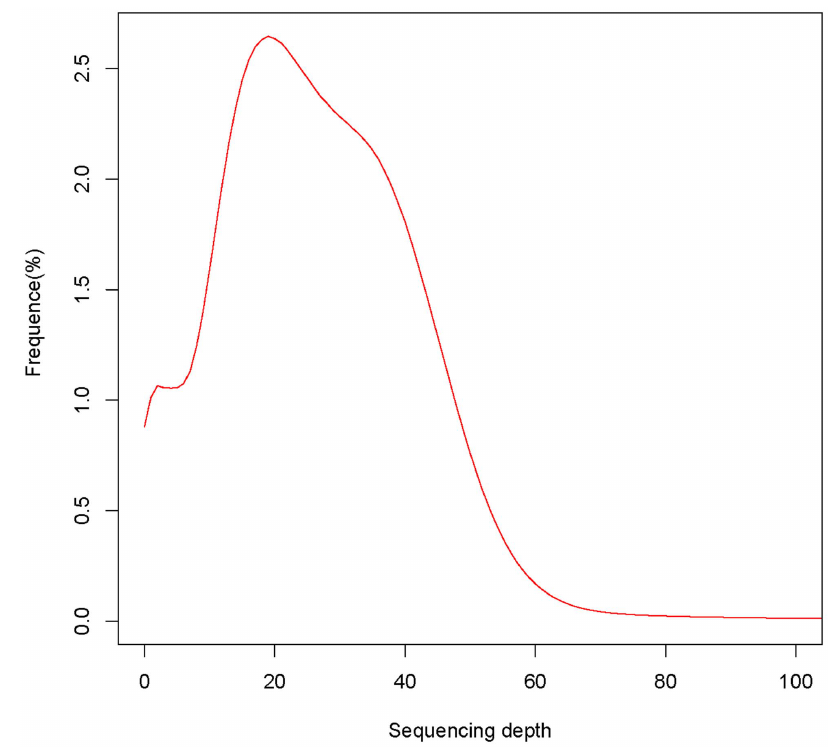
Figure 1. Distribution of sequencing depth.